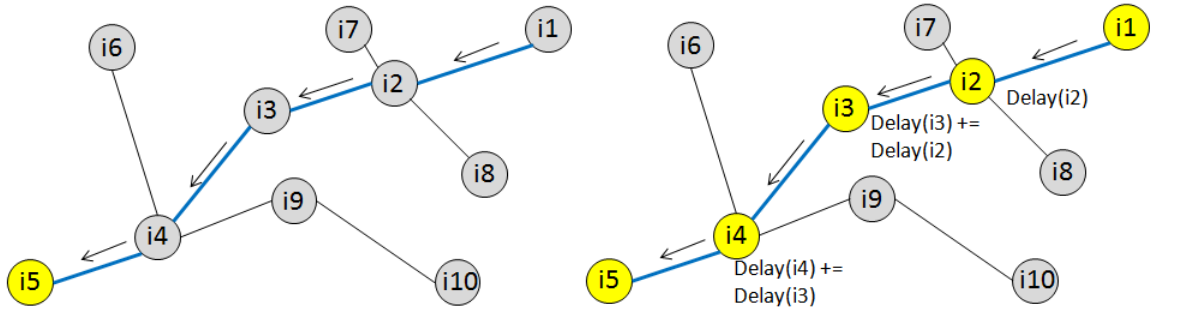
Figure 3. On the left, the routing protocol selects the path to connect two remote nodes i and i through the nodes i , i , and i . On the right, nodes experience communication delays 5 2 3 4 which are propagated down along the path from the source to the destination